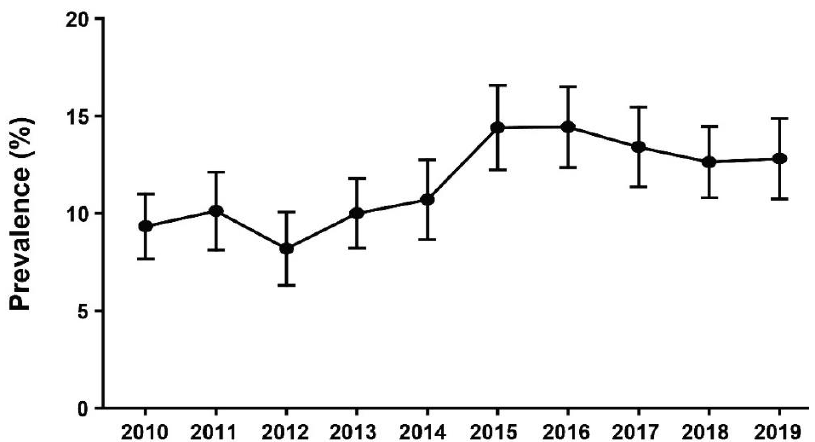
Figure 1. Annual prevalence (95% confidence interval) of OC use from 2010 to 2019.